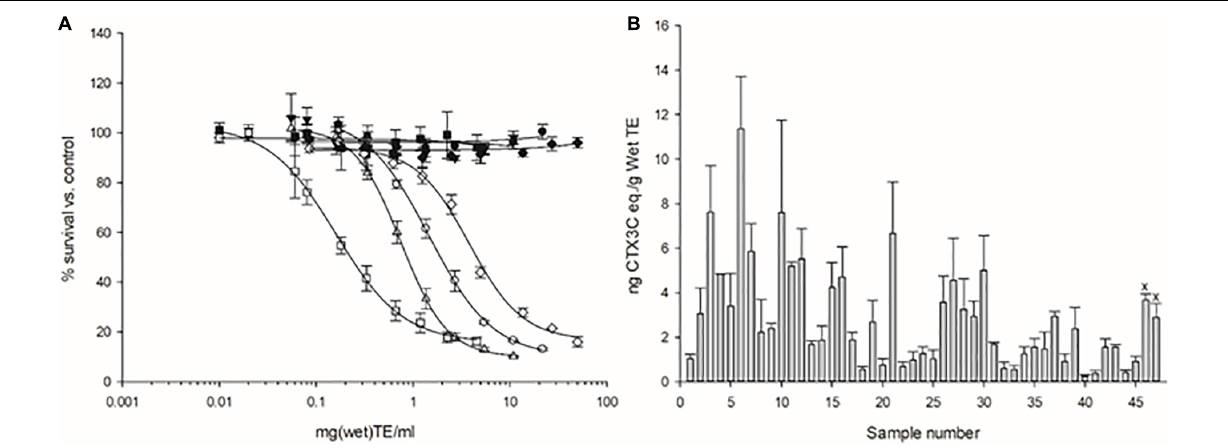
Therefore, both meal remnants exceeded the FDA guidance levels of 0.1 ng C-CTX-1 eq. per g and 0.01 ng CTX1B eq. per